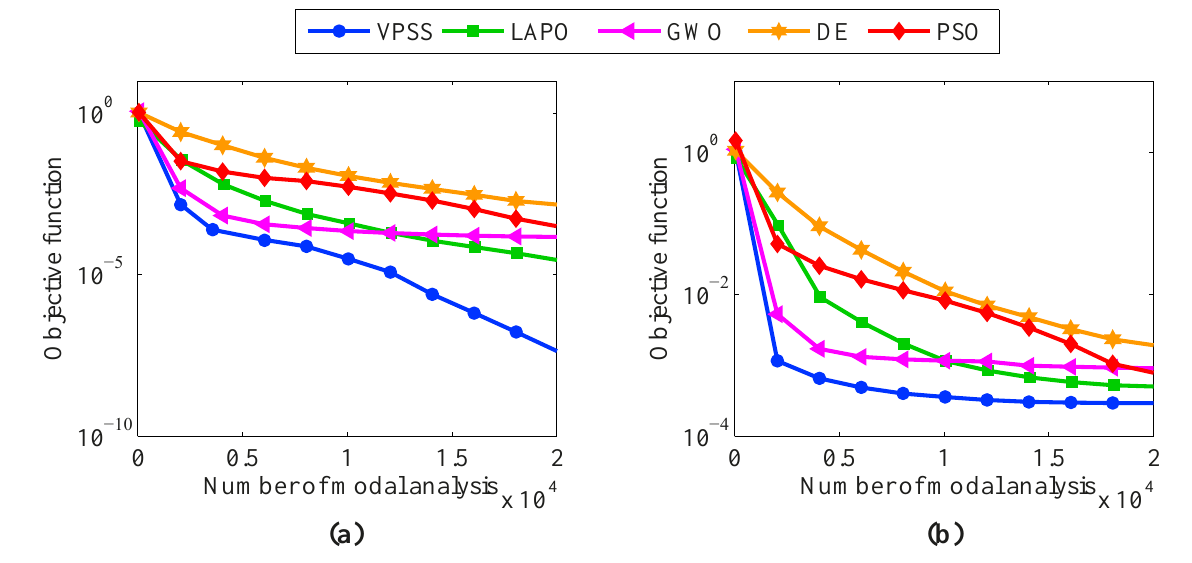
Figure 10. Convergence histories of mean objective function values of VPSS, LAPO, GWO, DE, and PSO for the 54-bar space truss in the ( a ) noise-free condition and ( b ) noisy condition.